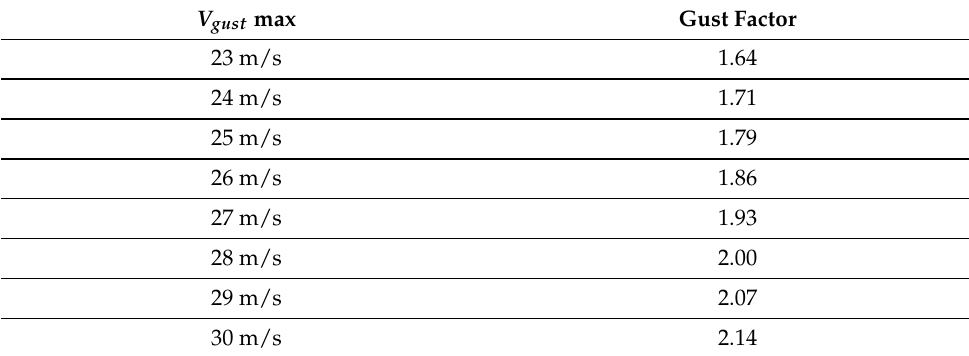
Table 2. ECG Input Gust Factors.